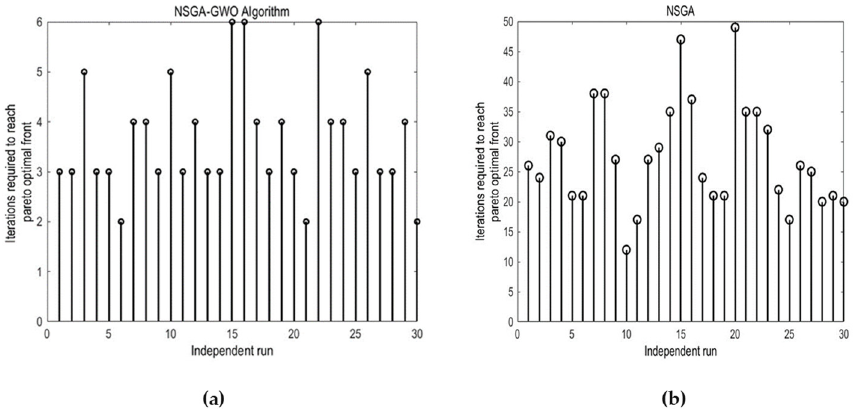
Figure 7. ( a ) Number of iterations required in each independent run to reach the pareto-optimal front employing NSGA-GWO algorithm. ( b ) Number of iterations required in each independent run to reach the pareto-optimal front employing NSGA II.